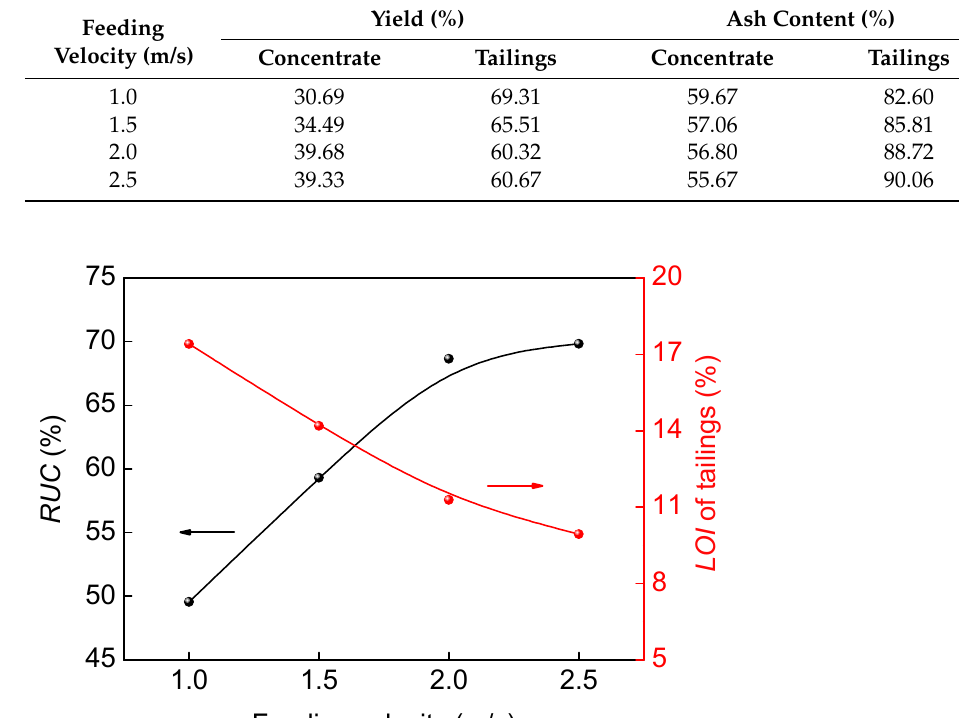
Table 2. Flotation products yield and ash content for different feeding velocities.